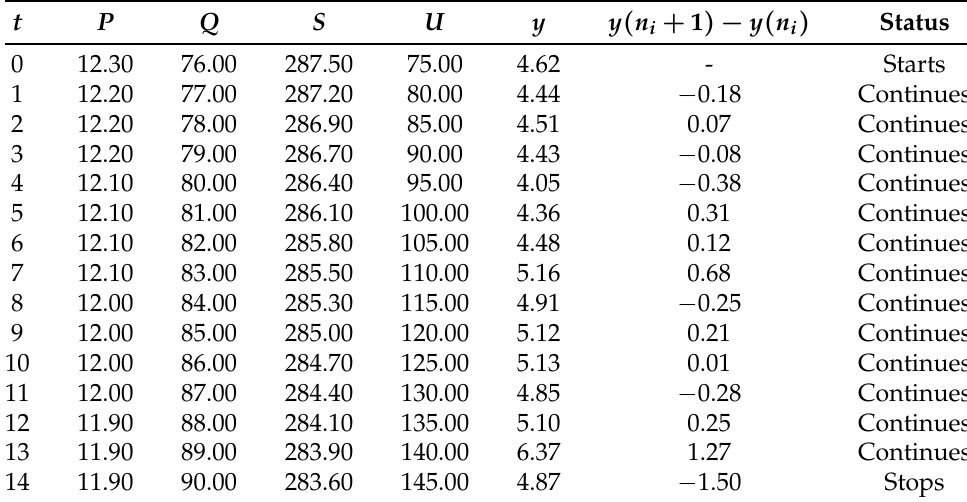
Table 3. Obtained results from MKSR procedure in Case 1.